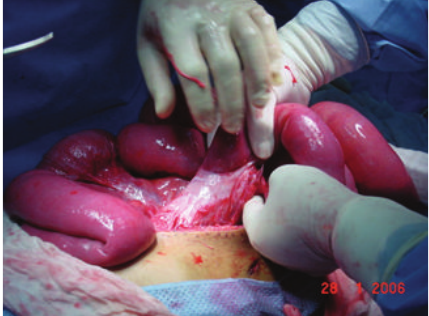
Figure 3: Displaying part of the adhesions.